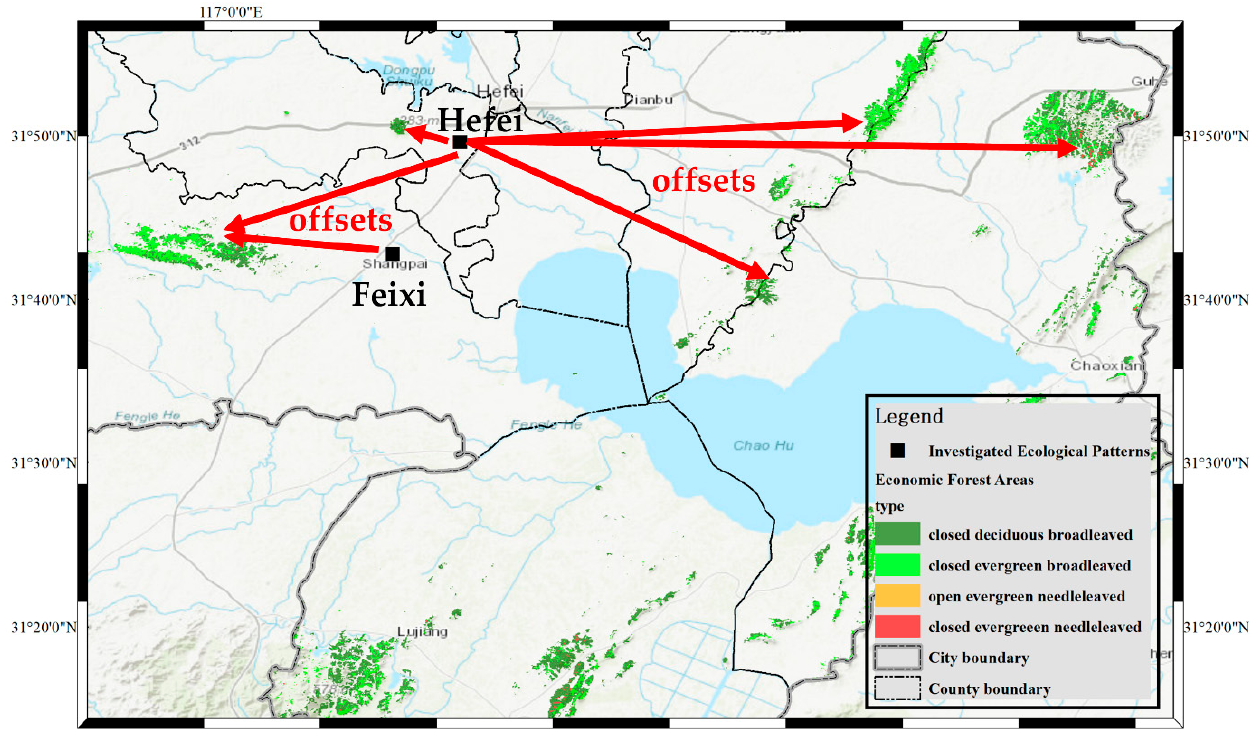
Figure 1. Offsets between the geo-parsed locations and the actual locations of ecological patterns in the example of a Hefei forest ecological pattern investigation.